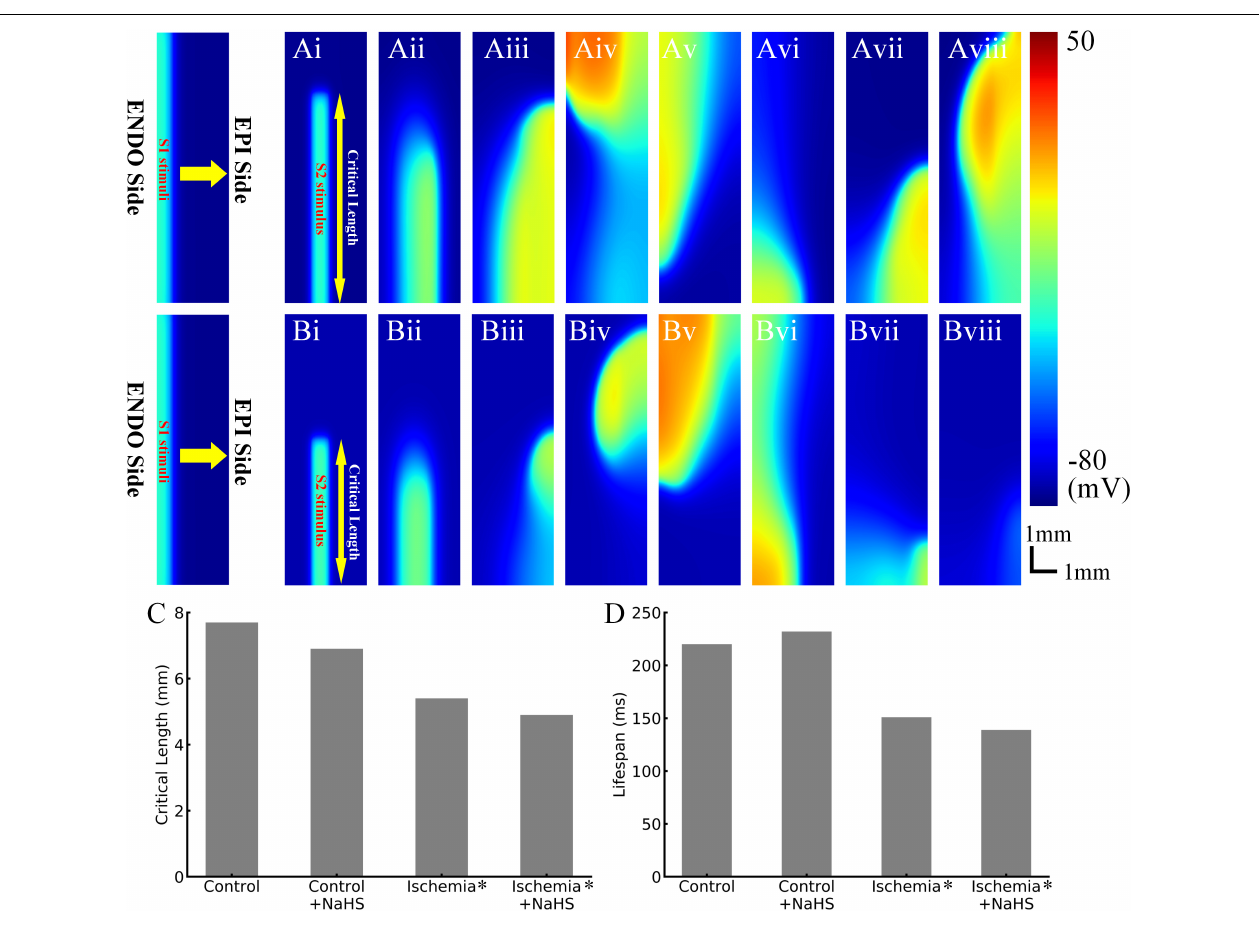
FIGURE 5 | Representative snapshots of initiated spiral waves in (Ai–Aviii) healthy tissues and (Bi–Bviii) early ischemic tissues. (C) The critical length in control/health, control/health +100 µ mol/L NaHS, early ischemia, and early ischemia +100 µ mol/L NaHS. (D) The life span of initiated reentry in four